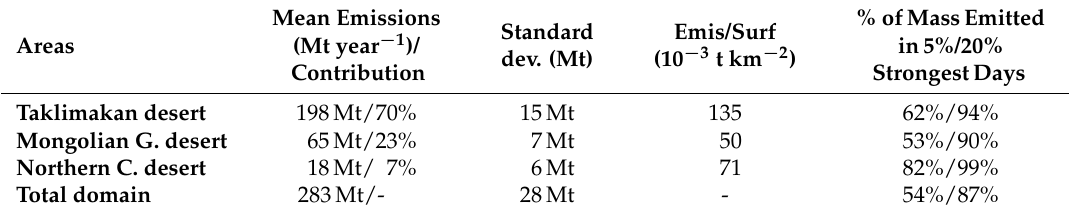
Table 1. Mineral dust emissions from the different source regions, annual average calculated from 2011, 2013 ad 2015 simulations. Last column indicates the proportion of mineral dust emitted during the 5% and 20% strongest emitting